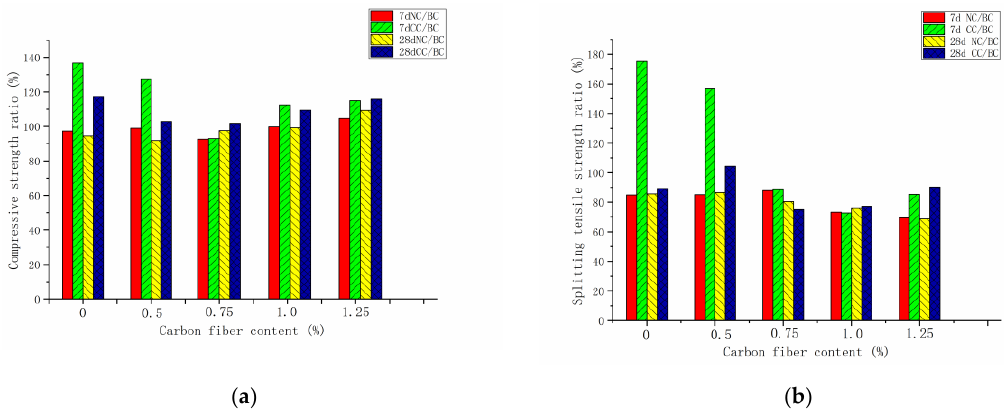
Figure 9. Carbon-fiber RPC strength versus standard curing strength ratio: ( a ) compressive strength ratio, ( b ) splitting tensile strength ratio.